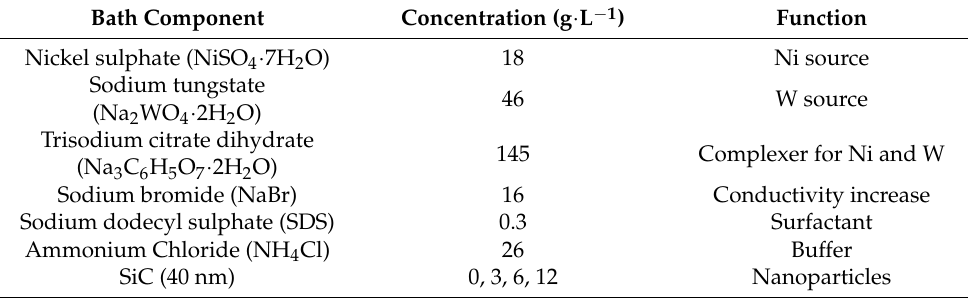
Table 2. Chemical composition of the electrolyte bath.